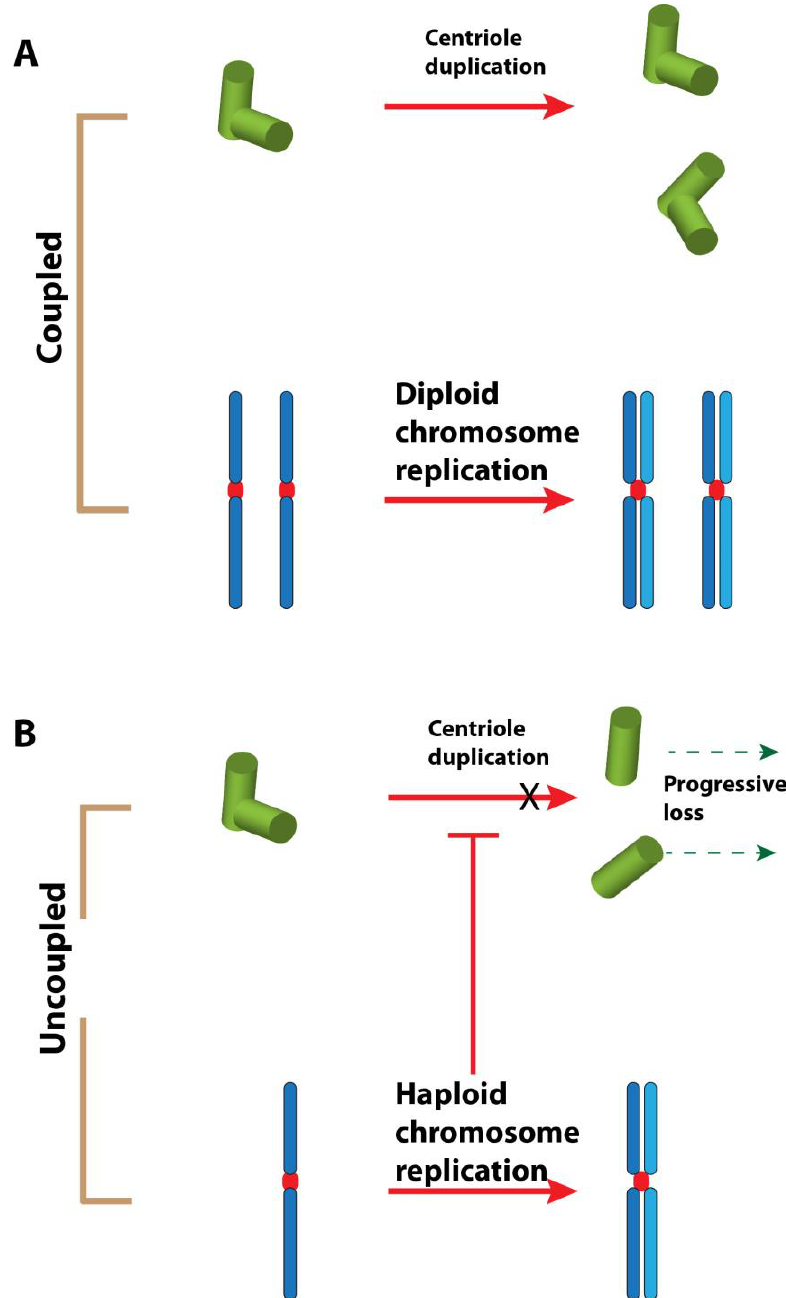
Figure 2. Hypothesis 2: haploidy causes centriole loss. A . In a diploid cell, the chromosome replication and centriole duplication cycles are tightly coordinated during the cell cycle. B. In a haploid cell, these events are uncoupled. The result could be an incomplete centriole duplication cycle. The licensing step for the duplication of the centriole could also be affected [54]. The repetition of uncoordinated events could lead to the loss of centrioles after some cell cycles.